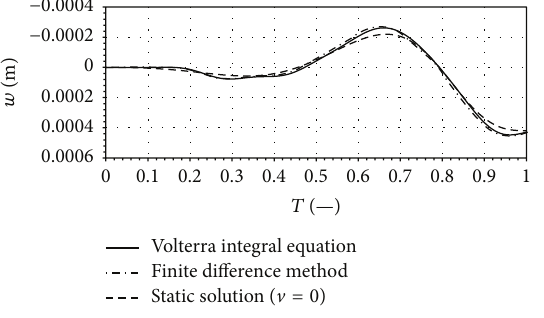
Figure 22: Dynamic deflection of point “c” due to a moving distributed load.